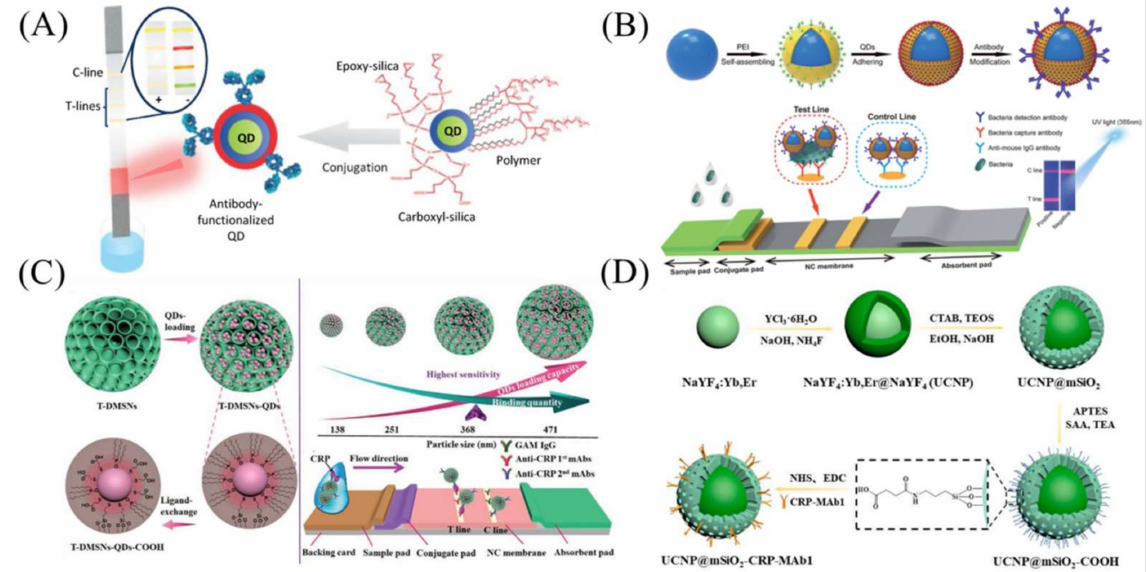
Figure 3. Silica-nanomaterial-assisted fluorescent LFA. ( A ) LFA using silica-shell-encapsulated QDs for simultaneous detection of four mycotoxins. ( B ) A core–shell SiO 2 -QD nanocomposite (SiO 2 @PEI- QD) was developed for use as an LFA label for rapid detection of Salmonella typhimurium in milk. ( C ) QDs were loaded into DMSNs for signal amplification, and the impacts of DMSN size on QD–DMSN interaction and the LOD of resultant LFA were also investigated. ( D ) Dendritic mesoporous silica-encapsulated UCNPs for SARS-CoV-2 detection. Reprinted with permission from References